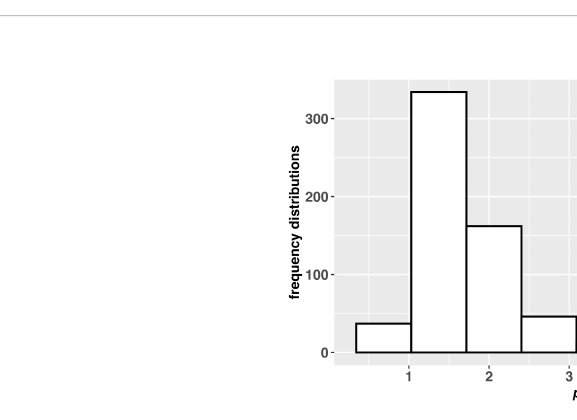
FIGURE 3 The frequency distribution of the fractal p . The interval with the highest percentage of p is [1.03 1.71) and its percentage is